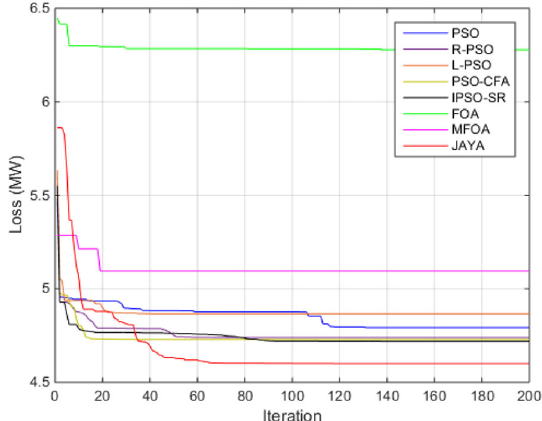
Fig. 3 Convergence characteristics of the algorithms for the IEEE 30 bus system without DG injection